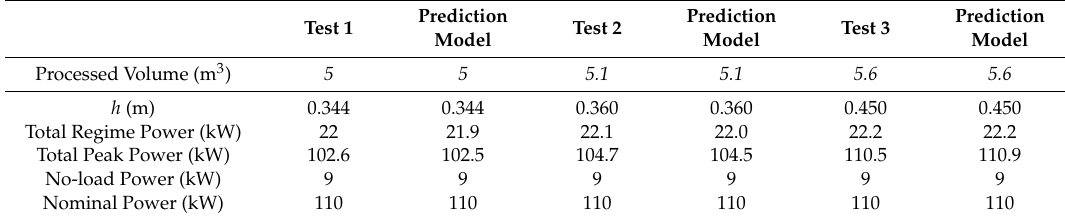
Figure 8. Experimental power consumption curve for h = 0.344 m and one single motor. Table 3. Power results from the experimental test and for the prediction model, for different filling levels h , considering both the motors of the machine.